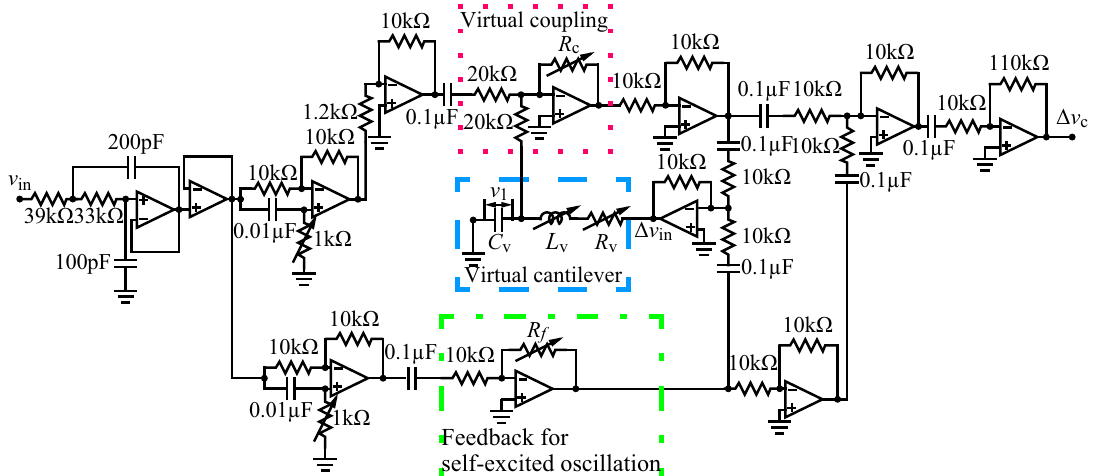
Figure 3. Analog circuit that implements the virtual cantilever and virtual coupling. The virtual cantilever’s dynamics are calculated by the RLC circuit enclosed by the dashed line. The resistance R v and inductance L v of the RLC circuit are tuned so that the virtual and real microcantilevers have the same eigenfrequency and damping ratio. The inter-terminal voltage of the capacitor in the RLC circuit is expressed as v 1 . We can regard v 1 as a physical quantity that is proportional to the virtual cantilever’s displacement. The virtual coupling effect is calculated by the summing amplifier enclosed by the dotted line. The coupling stiffness between the real and virtual cantilever is tuned by the feedback resistance R c . The feedback for self-excited oscillation is produced by the inverted amplifier enclosed by the chain line. The feedback gain for self-excited oscillation is tuned by the feedback resistance R f